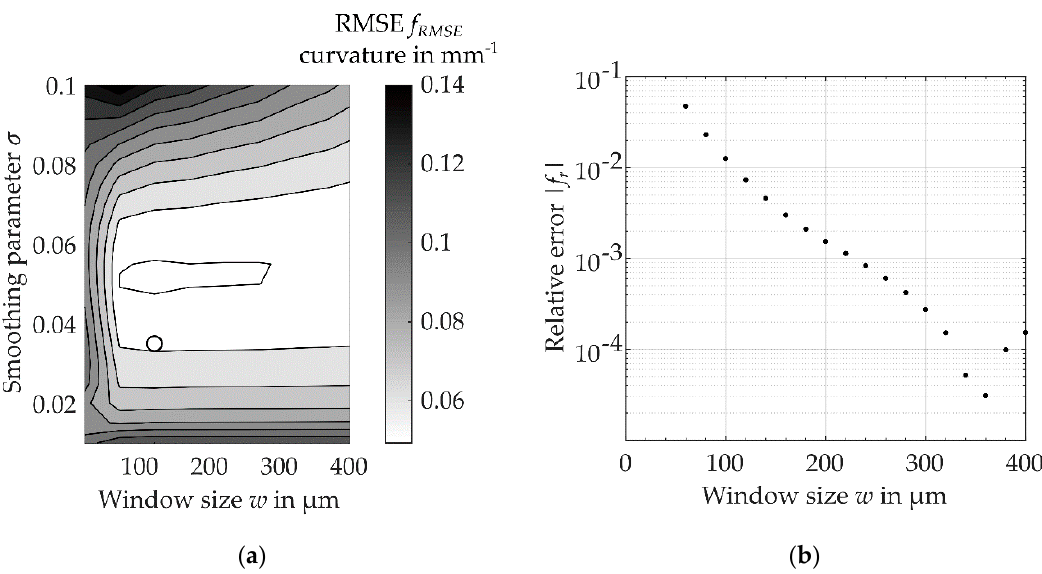
Figure 5. Error of canal curvature and length using the implemented evaluation algorithm for the centre line of the artificial root canal with random error in both transversal directions 𝑥 (cid:2869) and 𝑥 (cid:2870) : ( a ) root mean square error (RMSE) for different smoothing parameters 𝜎 and 𝑤 with selected parameters (circle, 𝜎 = 0.035, 𝑤 = 120 µm), ( b ) relative error 𝑓 (cid:3045) of the calculated canal length for different window sizes 𝑤 .